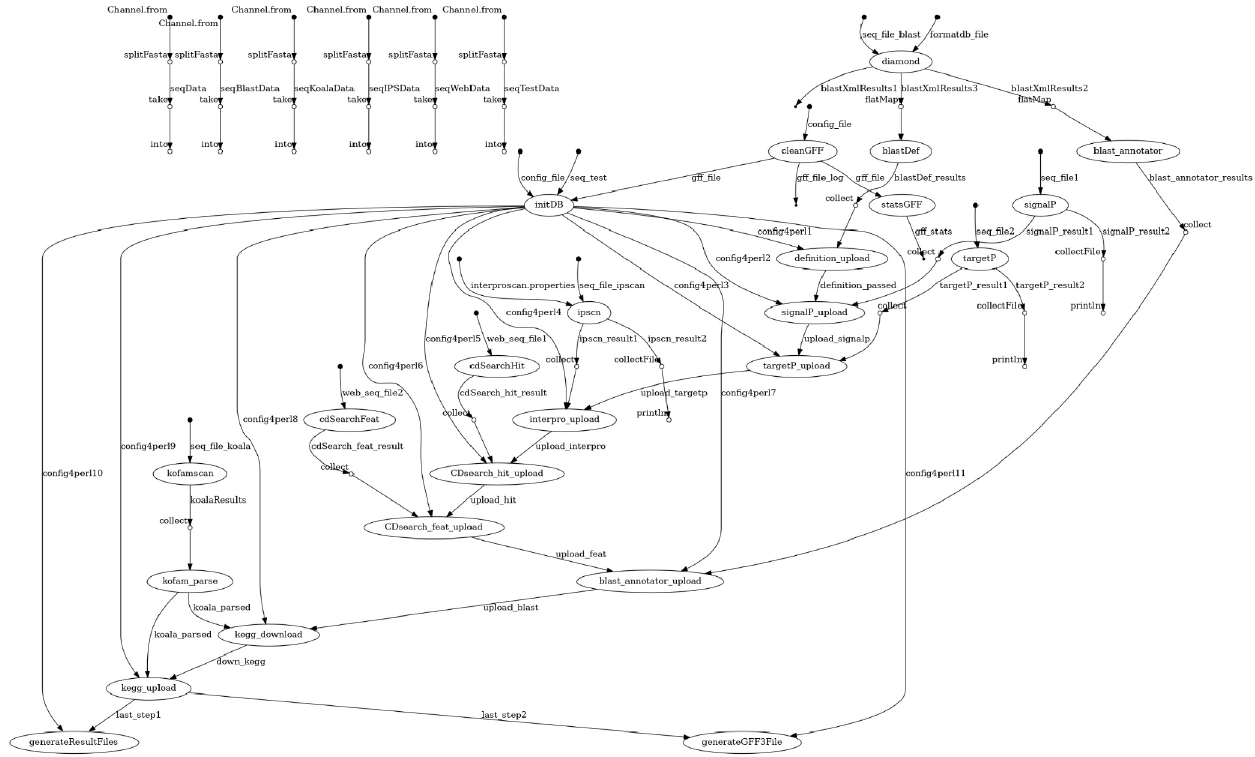
Figure 2. Automatically generated schema from Nextflow output.